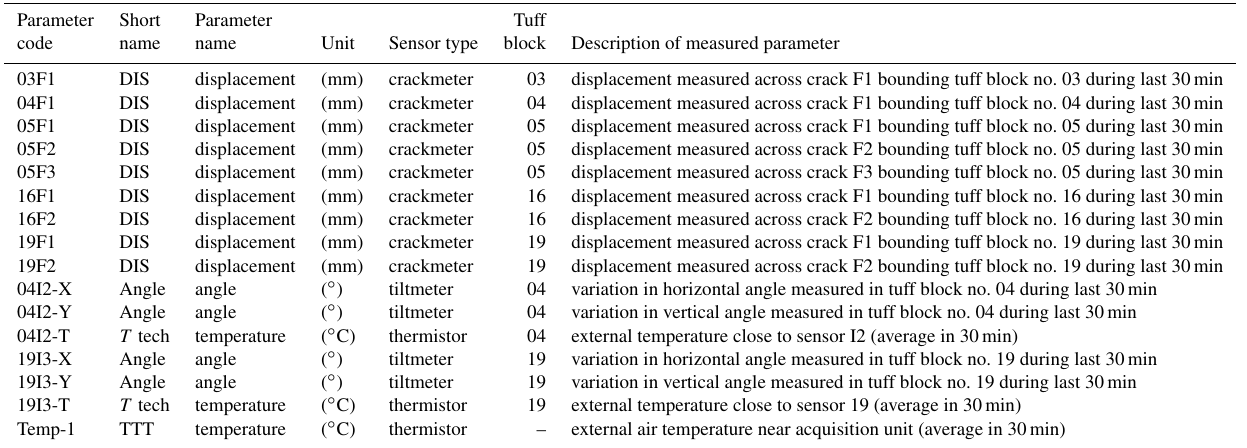
Figure 6. Data distribution of measurements of crackmeters (03F1, 04F1, 05F1, 05F2, 05F3, 16F1, 16F2, 19F1 and 19F2). Table 4. List of measured tuff deformation parameters in CC-MoSys.